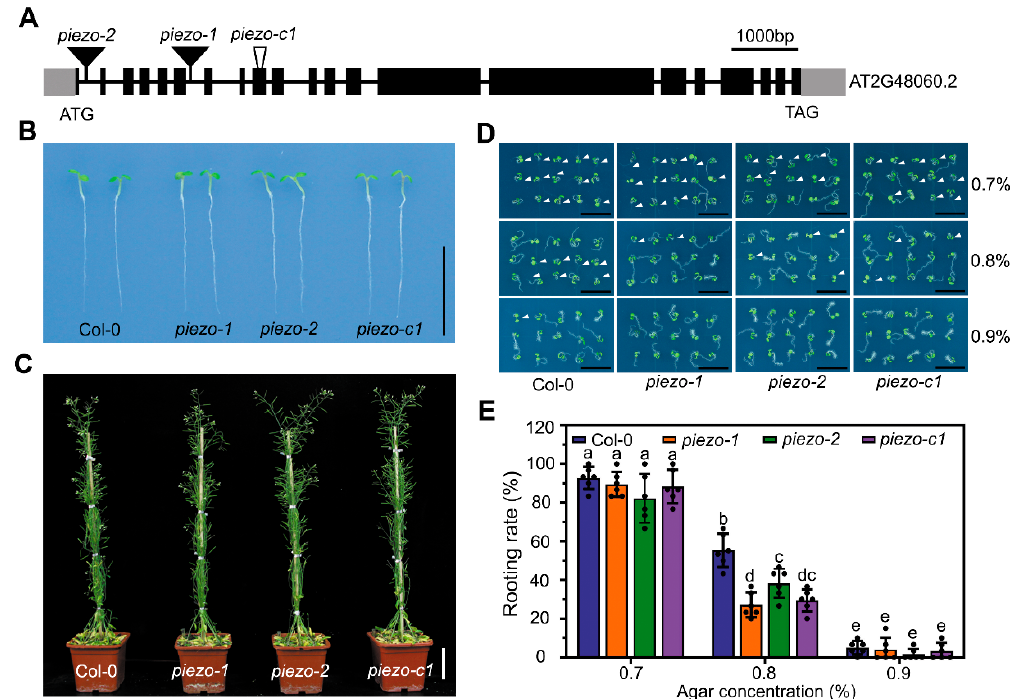
Figure 3. atpiezo mutants exhibit reduced rooting ability. ( A ) Schematic diagram of AtPiezo gene structure. Exons are indicated by black boxes. The black lines represent introns. Untranslated regions are indicated by gray boxes. The insertion sites of two T-DNA insertion alleles are indicated by the black solid triangles. The allele of delete fragment is indicated by the black hollow triangle. Bar = 1000 bp. ( B ) Representative images of WT and atpiezo mutants grown on 1/2MS medium five days after germination, Bar = 1 cm. ( C ) Representative images of WT and atpiezo mutants grown in the soil 55 days after germination. Bar = 5 cm. ( D ) The rooting phenotype of Col-0, piezo-1 , piezo-2 and piezo-c1 horizontally grown on the agar medium. Five-day-old seedlings of different plant lines were grown on the medium containing 0.7%, 0.8%, or 0.9% agar. White solid arrows indicate the seedlings rooting in the medium. Bar = 1 cm. ( E ) The rate of WT and atpiezo mutants foraging into the medium five days after germination. Data are presented as mean ± SD ( n = 6 plates, more than 30 seedlings in each plate) and analyzed with two-way ANOVA and Tukey’s multiple comparison test (Different lowercase letters indicate significant differences at p < 0.05).